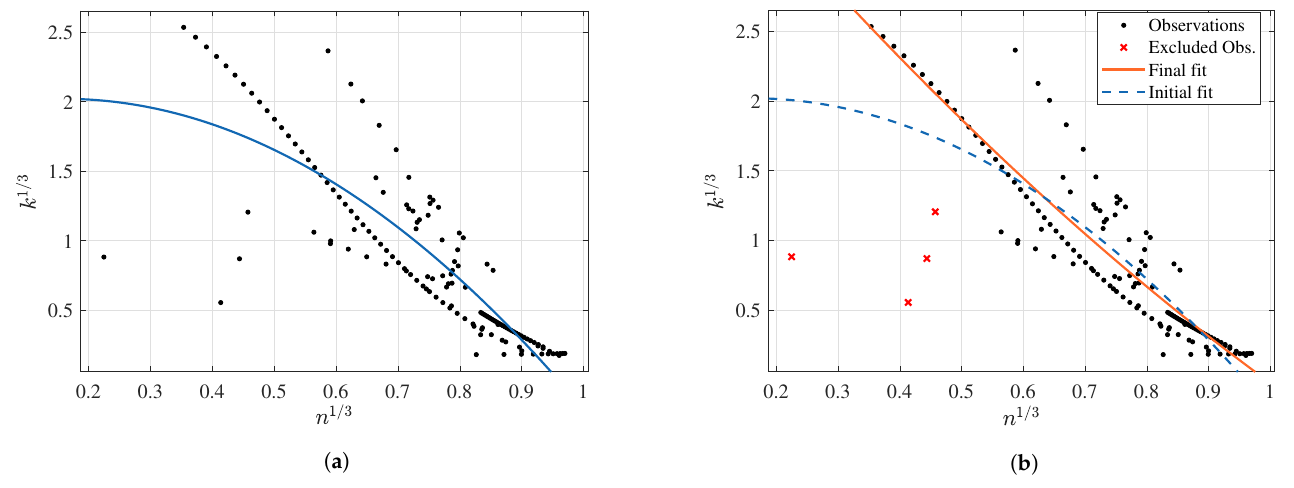
Figure 16. Exponential regression results of k 13 and n 13 for the AS dataset: ( a ) initial fitting and ( b ) fitting after